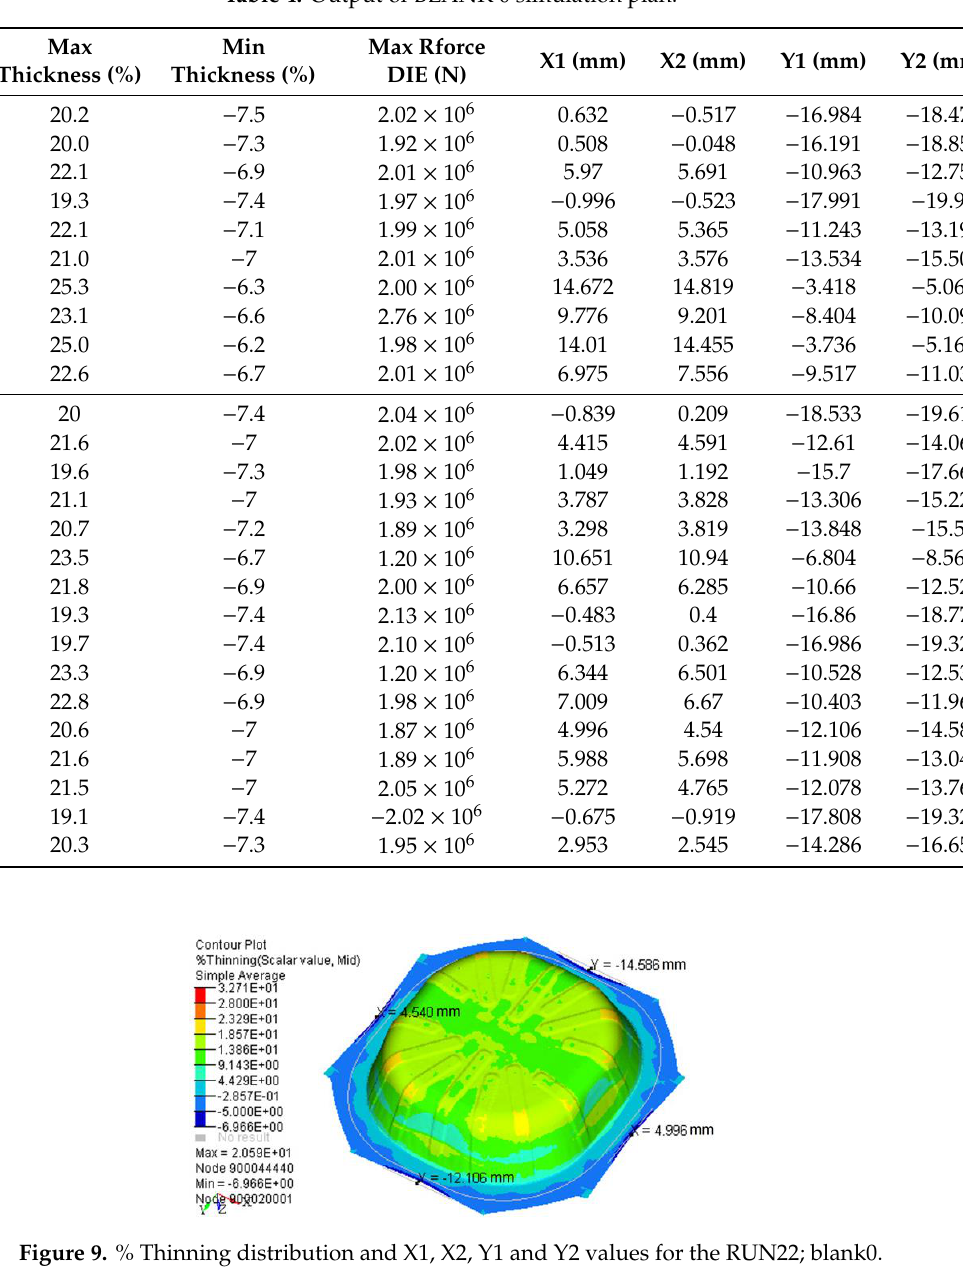
Figure 11. % Thinning distribution and X1, X2, Y1 and Y2 values for the RUN1; blank1. Figure 12. % Thinning distribution and X1, X2, Y1 and Y2 values for the RUN11; blank1. Figure 13. Reaction force curves comparison between RUN20 and RUN22; blank0. Figure 14. Punch displacement with stepwise, in correspondence of S and T1. TT represents the last point of the curve with maximum value in the x axis; blank0.